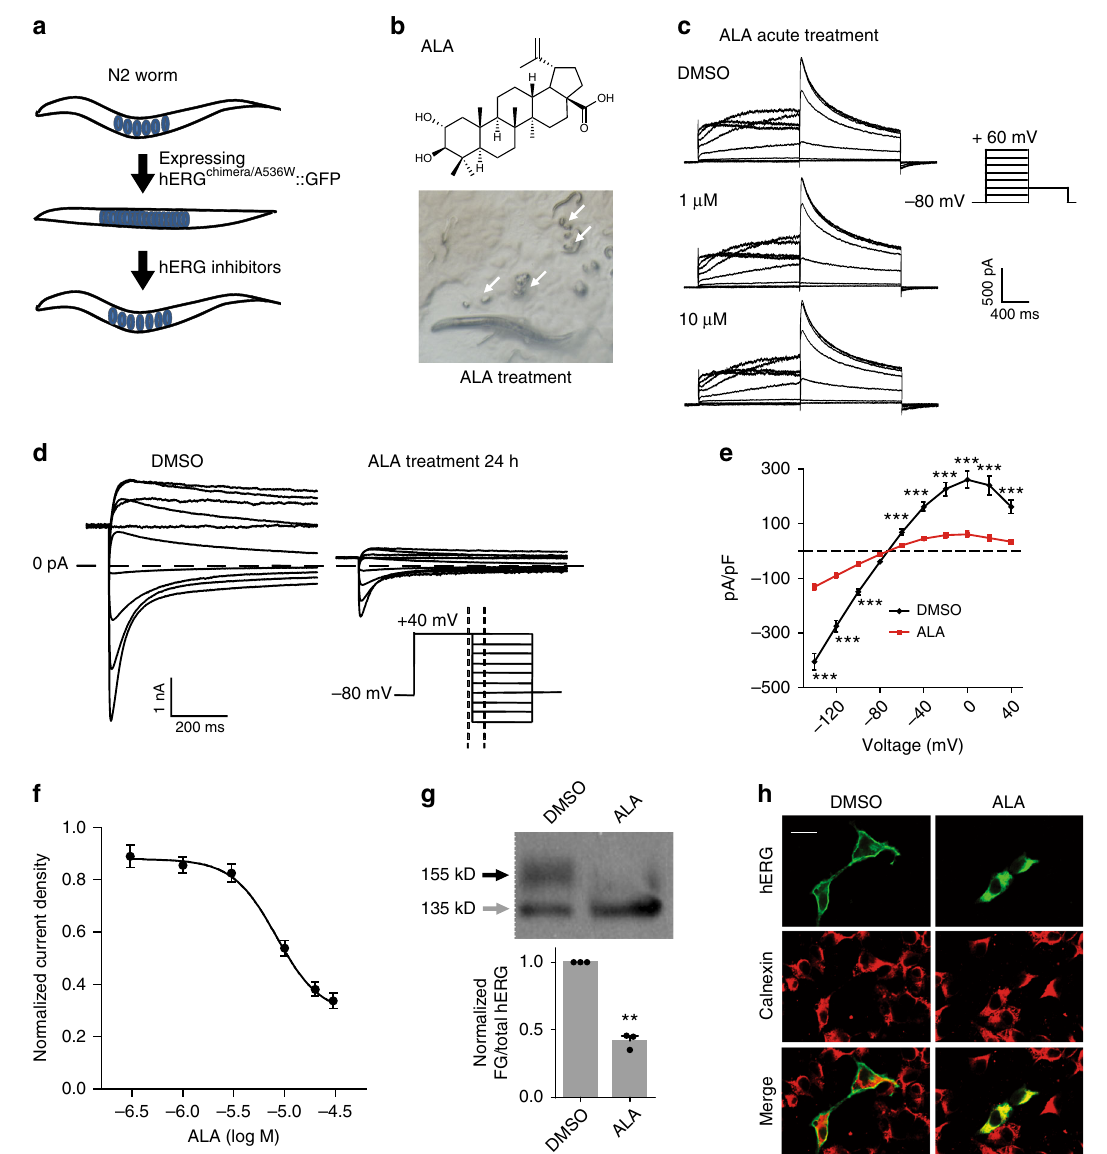
Fig. 2 A small-molecule screen in C. elegans identi fi es a novel hERG traf fi cking inhibitor. a Schematic illumination of the screening assay. b Molecular formula of alphitolic acid (ALA, upper) and microscopic images of acs-20;hERG chimera/A536W transgenic worms in the presence of 20 µ M ALA in cultivating plates (lower). White arrows indicate eggs. c Representative whole-cell currents of HEK293T cells expressing wild-type hERG channels before or after treated with 1 or 10 µ M ALA. n = 6 cells. d , e Representative whole-cell currents and I / V curves of wild-type hERG channels expressed in HEK293T cells treated with DMSO ( n = 19) or 20 µ M ALA ( n = 25) for 24 h. The protocol is shown in the lower right of d , and traces at the time course between two dashed lines are shown. f Dose-dependent effects of long-term ALA treatment on the current densities of wild-type hERG channels recorded at a membrane potential of − 140 mV. n ≥ 20 cells per dose were recorded and analyzed. g Western blot analysis of hERG proteins expressed in HEK293T cells treated with DMSO or 20 µ M ALA for 24 h (top), and quantitantive analysis of the ratio of fully glycosylated (FG, 155 kD) to total hERG proteins (down). Black and gray arrows indicate 155 kD and 135 kD bands of hERG proteins, respectively. h Immunostaining of hERG and ER marker protein Calnexin in HEK293T cells treated with DMSO or 20 µ M ALA for 24 h. Scale bar: 20 µ m. Data shown are mean ± s.e.m. ** P < 0.01,*** P < 0.001 (Student ’ s t -tests for e , g ). All experiments were performed at least three